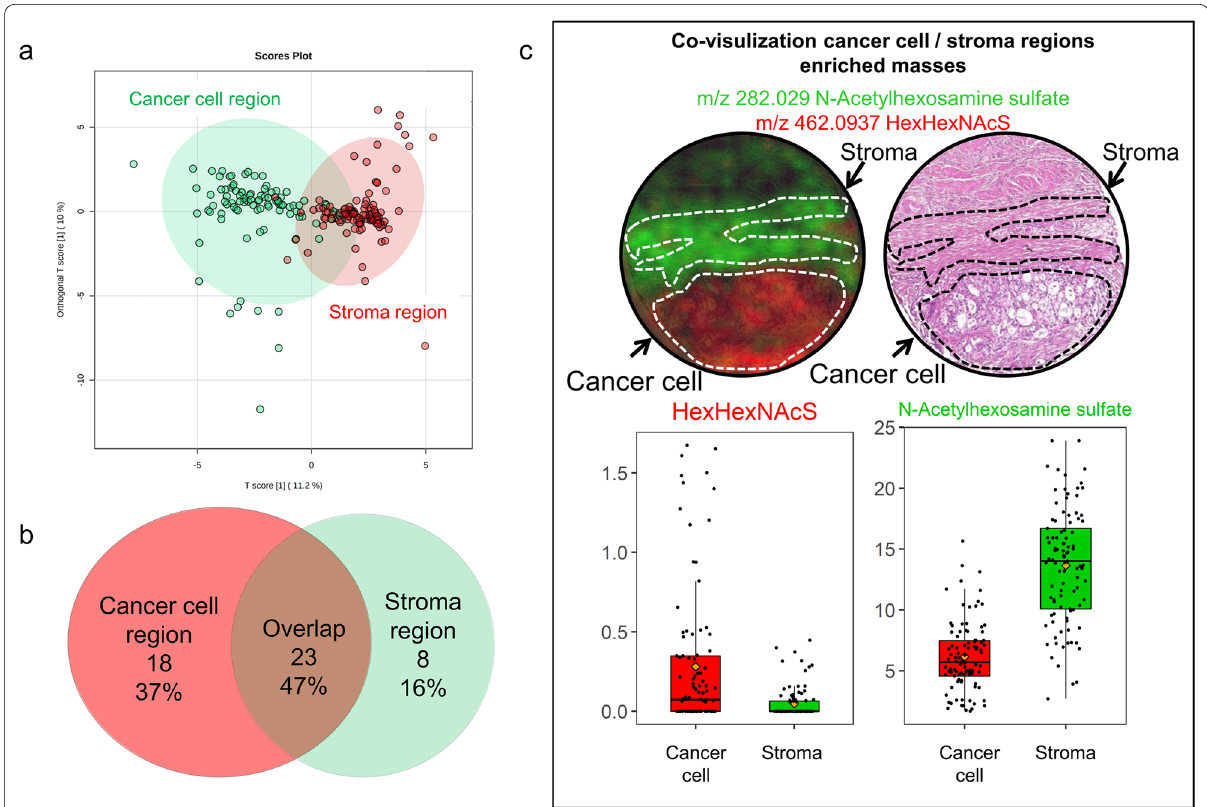
Fig. 1 a Ortho‑PLSDA of cancer cell and stroma region based on glycan intensities. b Venn diagram indicating common and distinct glycan fragments detected in cancer cell and stroma regions, respectively. c Example of glycan fragments differently expressed in tumor and stroma region, respectively. Co‑visualization of HexHexNAcS (red color) and N ‑Acetylhexosamine sulfate (green color) representing different distributions in the cancer cell and stroma